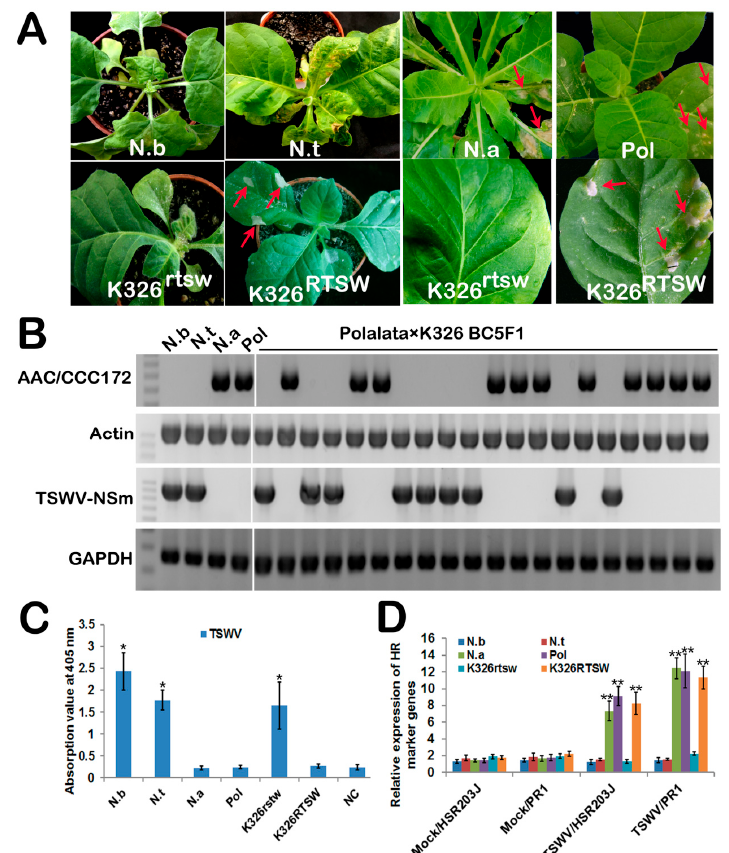
Figure 1. Tobacco plants harboring the resistance to Tomato spotted wilt virus (RTSW) gene demonstrate resistance to the Tomato spotted wilt virus (TSWV) via a hypersensitive response (HR). ( A ) Phenotype of tobacco leaves inoculated with TSWV. N.b, Nicotiana benthamiana ; N.t, N. tabacum cv. K326; N.a, N. alata ; Pol, Polalta; K326 rtsw , plants derived from the backcross segregating (BC5F1) population of Polalta × K326 cross lacking the RTSW gene and susceptible to TSWV; K326 RTSW , plants derived from the same BC5F1 population but carrying the RTSW gene and are hence resistant to TSWV. Photographs of plants were taken at 14 days post-inoculation (dpi). Bottom two panels on the right show enlarged views of K326 rtsw and K326 RTSW leaves. Red arrows indicate HR symptoms in inoculated leaves. ( B ) Genotyping using SCAR markers S-AAC/CCC172 linked with the TSWV resistance gene (top two panels), and reverse transcription-polymerase chain reaction (RT-PCR) analysis of systemic infection of TSWV (bottom two panels) in tobacco plants. For RT-PCR, RNA of un-inoculated upper leaves was used as a template for the non-structural protein (NSm) gene amplification at 14 dpi. Actin and glyceraldehyde-3-phosphate dehydrogenase (GAPDH) genes were